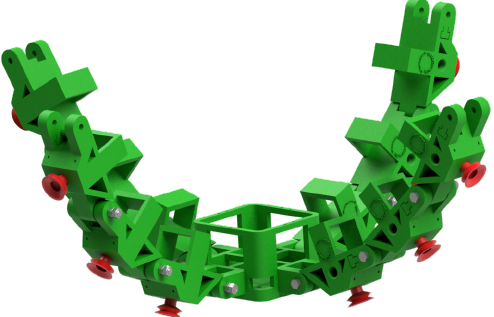
Figure 1. Rendering of the proposed vacuum gripper